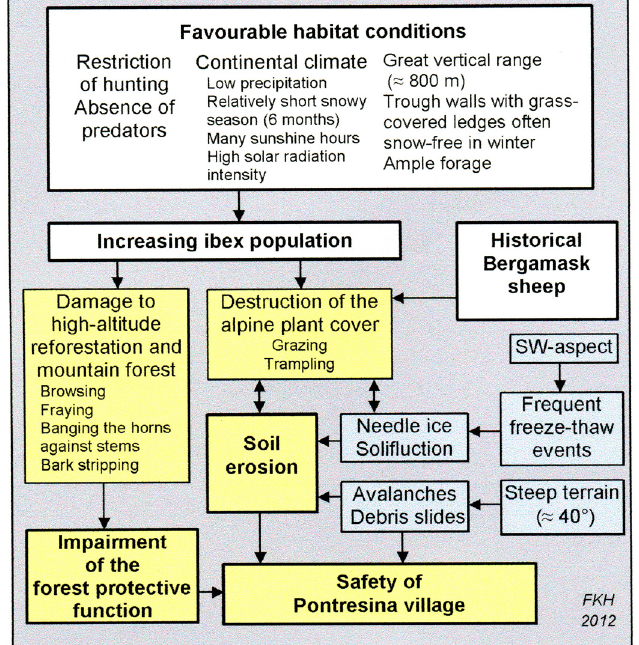
Figure 10: Large ibex numbers and after-effects of historical seasonally migrating (transhumance) Bergamask sheep herds (white boxes) affect high-altitude reforestation and subalpine forest and increase soil erosion in the ibex reserve (yellow boxes). Soil erosion is enforced by natural physical factors (blue boxes). This situation may threaten the safety of Pontresina